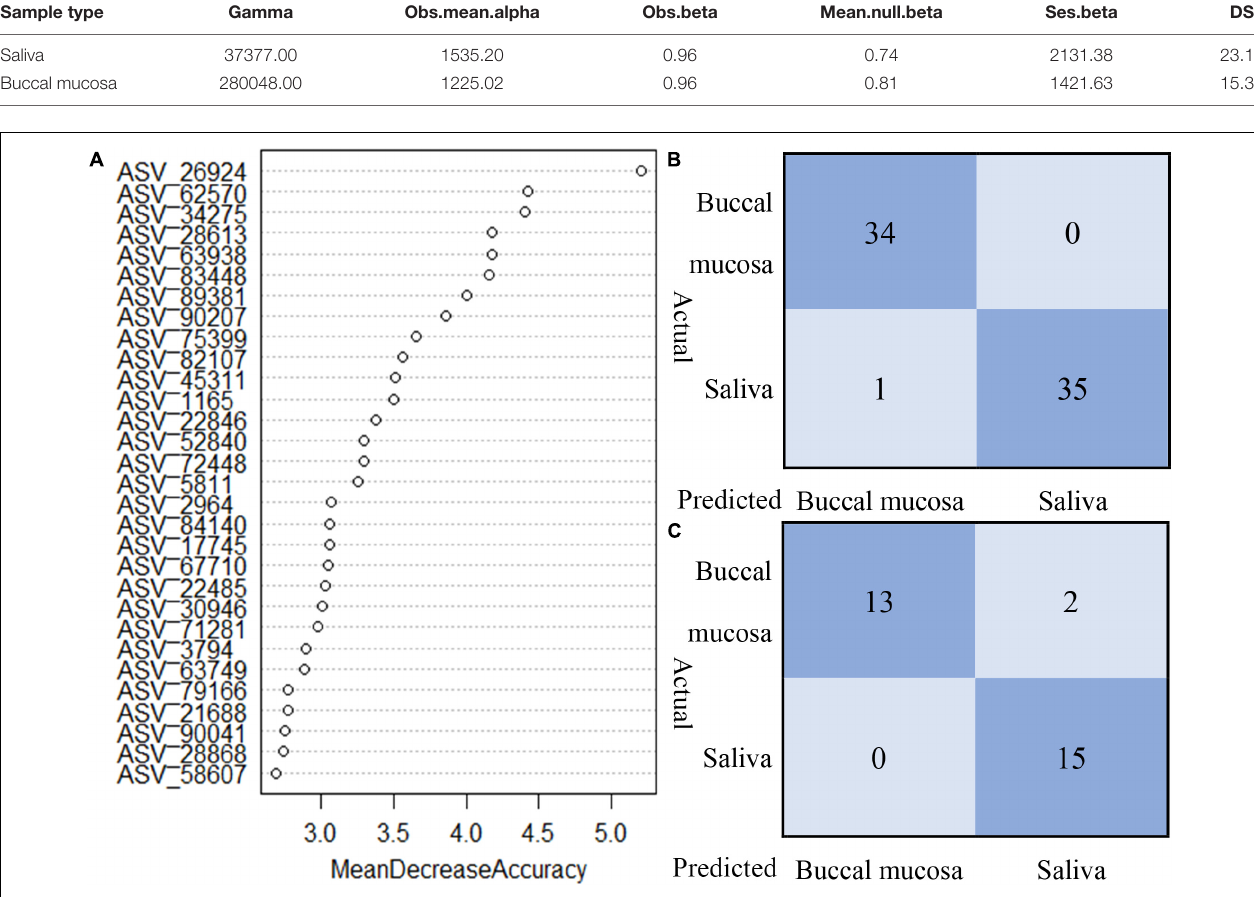
FIGURE 5 | The random forest model to classify the origin of sample type. (A) Top 30 important ASVs to perform the prediction. (B) Train data showed 98.57% of true predictions represented the good fitness of the model. (C) Test data showed 93.33% of true prediction, with mismatching of two samples in test